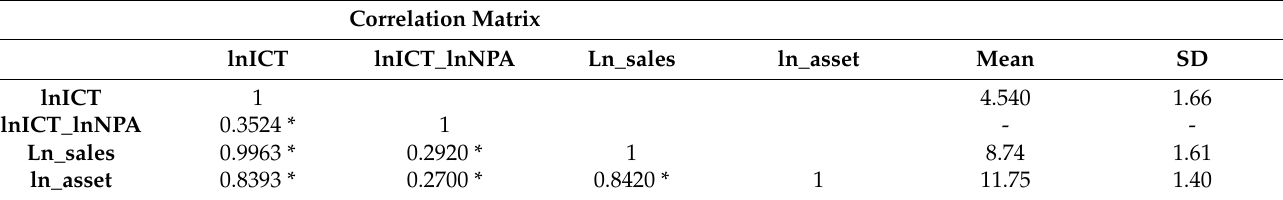
Table 2. Descriptive Statistics and Correlation